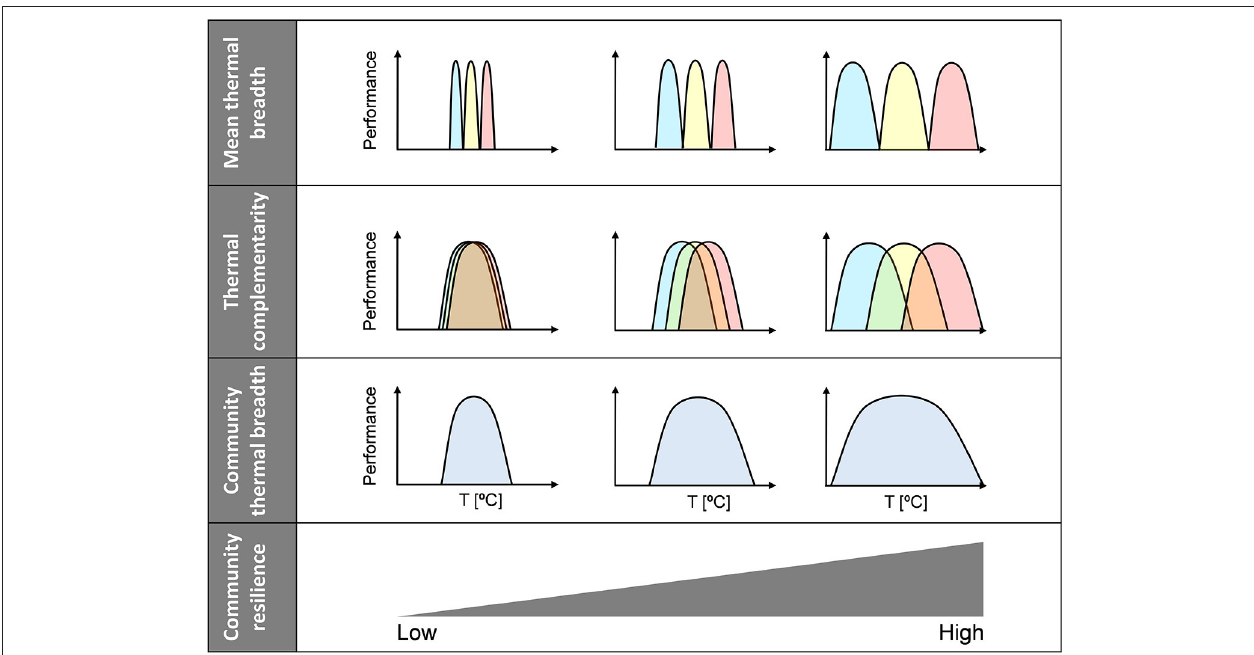
FIGURE 2 | Community resilience scenarios. Relationships between community thermal resilience and community thermal breadth, mean thermal breadth, and thermal complementarity. Communities have been simplified to include three species and only extreme scenarios are depicted; note, however, that there might be a continuum of community resilience. Community thermal breadth increases from left to right because both mean thermal breadth and thermal complementarity increase.